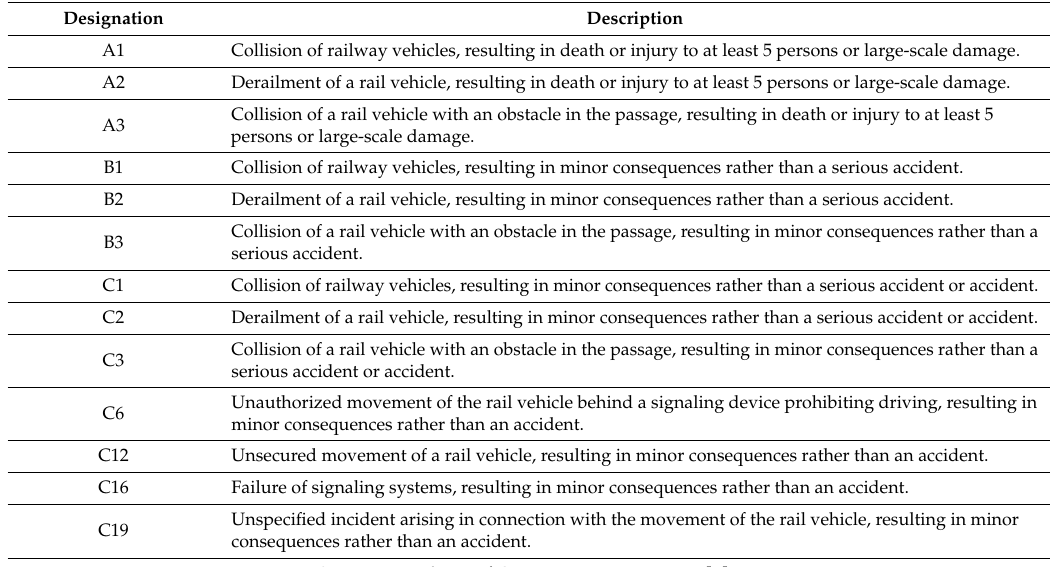
Table 2. Categories of occurrences.